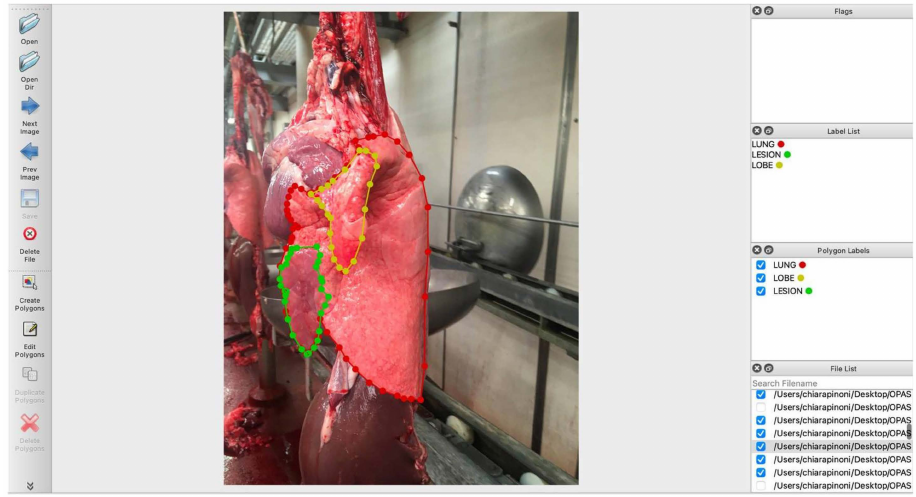
Figure 2. Label me annotation tool. In this case, three areas have been annotated, i.e., the silhouette of the left lung (“lung”, red dots and lines), the flipped cranial lobe (“lobe”, yellow dots and lines) and an EP-like lesion (“lesion”, green dots and lines). Both lobe and lesion are fully embedded within the “lung”